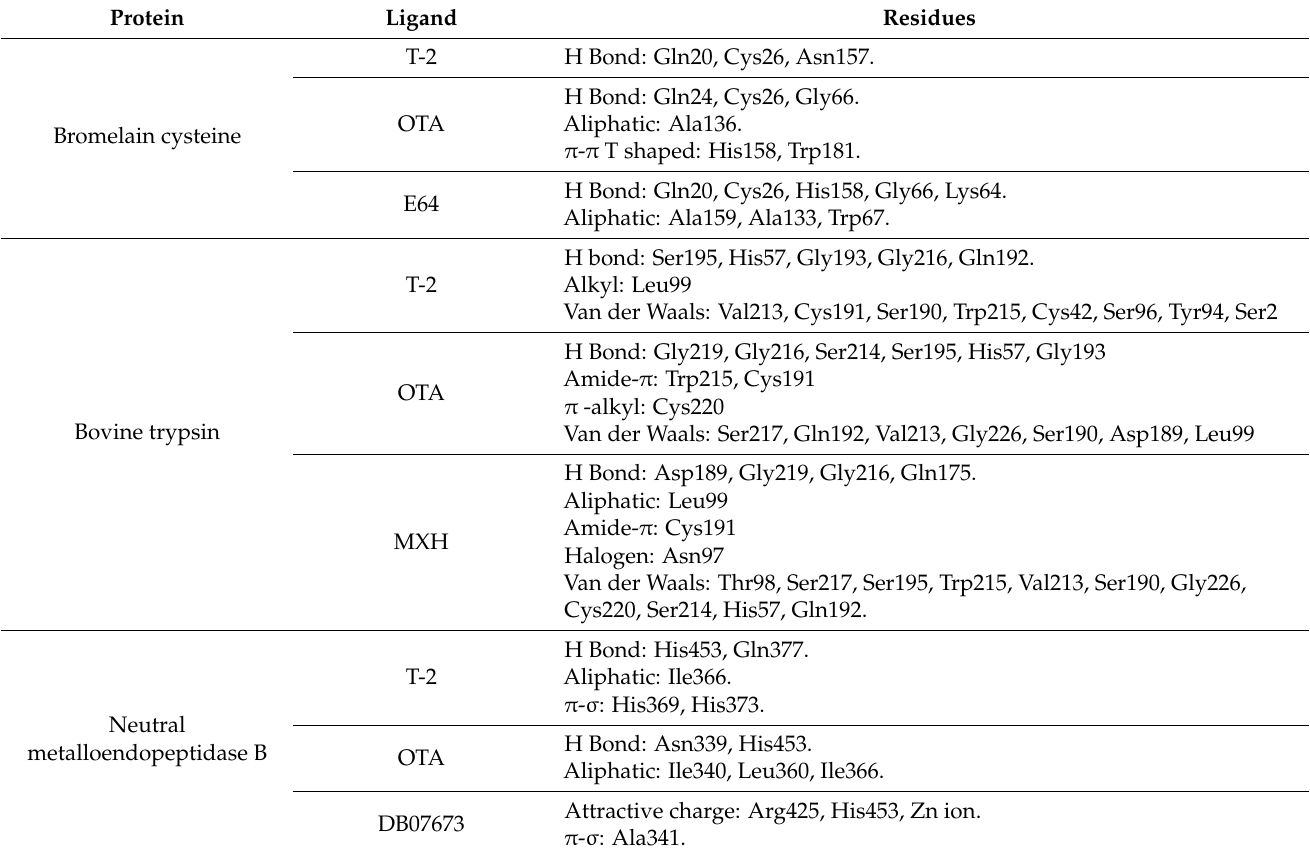
Table 3. Protein–ligand main